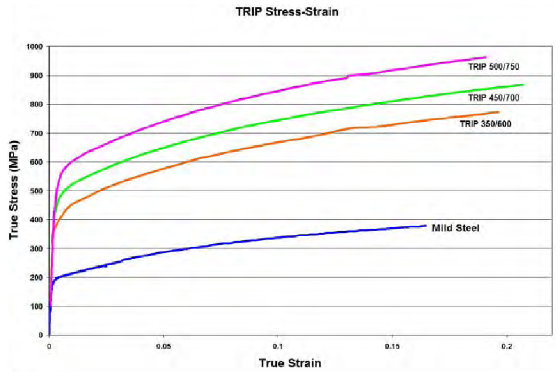
Figure 10. True stress ‐ strain curves for TRIP steel grades.